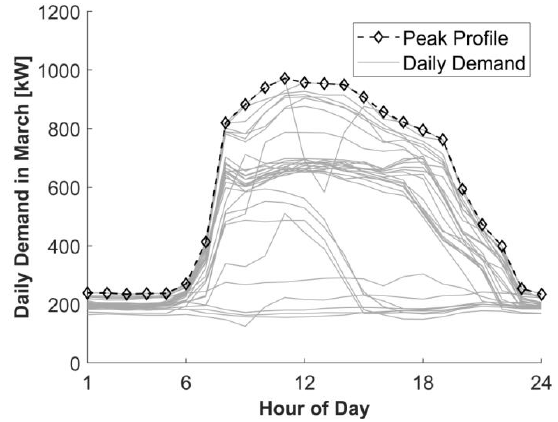
Figure 3. Daily demand for each day in an example March month and peak demand day profile constructed from selecting maximum hourly demand across all days.